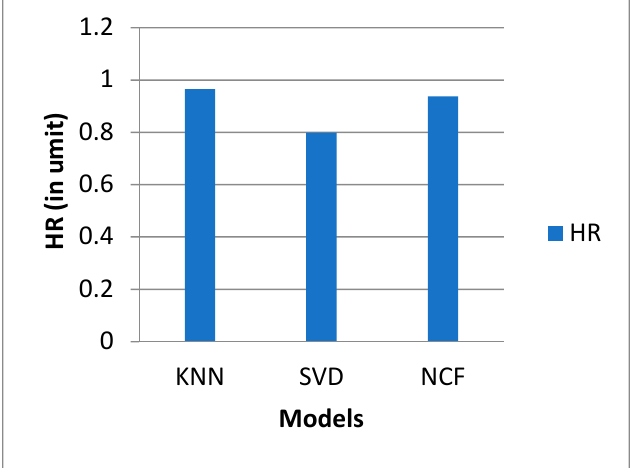
Figure 14. Performance results of different models in terms of HR in 80:20 training–testing scenario.